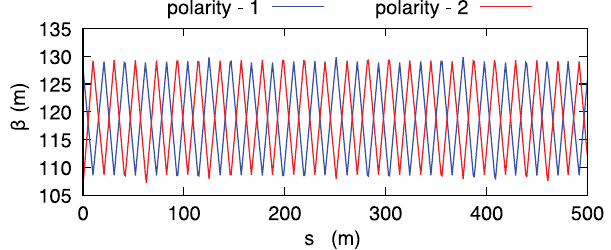
FIG. 2. The vertical beta-function values around the ring for CW and CCW operations. They flip sign when the magnetic quadrupoles are running with the opposite sign and therefore the counter-rotating particles on average trace the same paths.